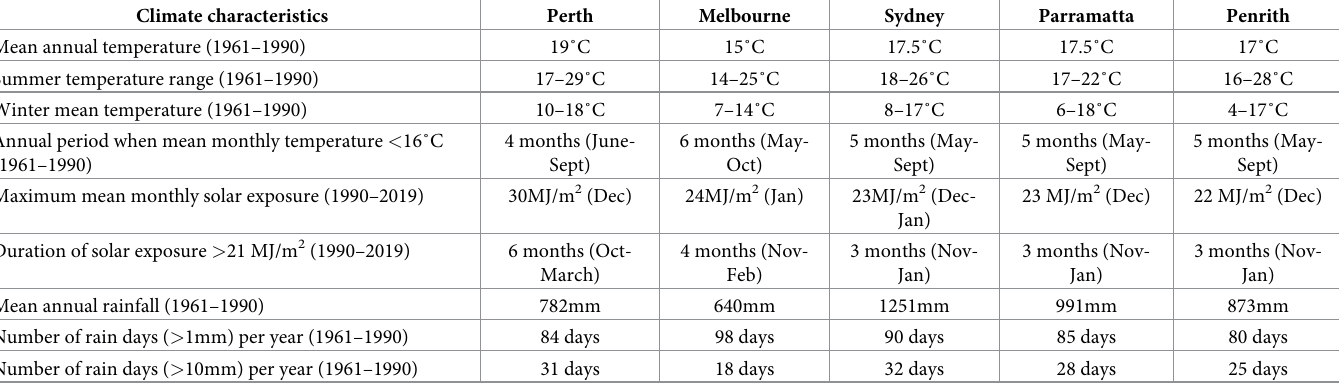
Table 4. Climate patterns in the stations sampled, based on 30 years of data, Australian Bureau of Meteorology [28–30,33]. The 30-year period used to assess each climate characteristic is outline in parenthesis. Climate